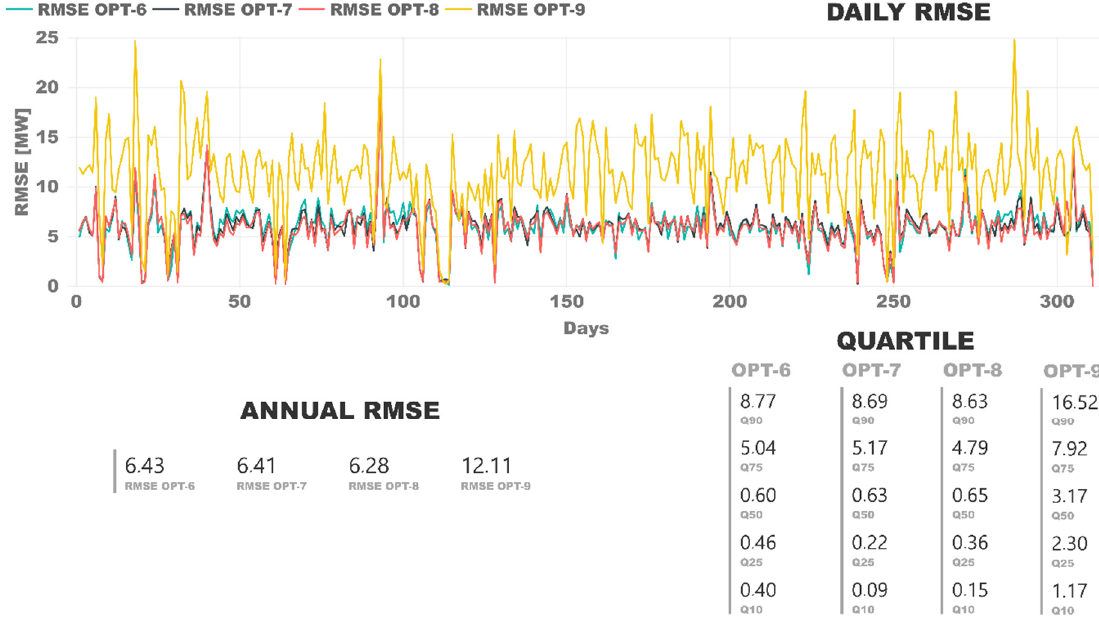
Figure 6. Comparison of Model RMSE with Plant B validation data.